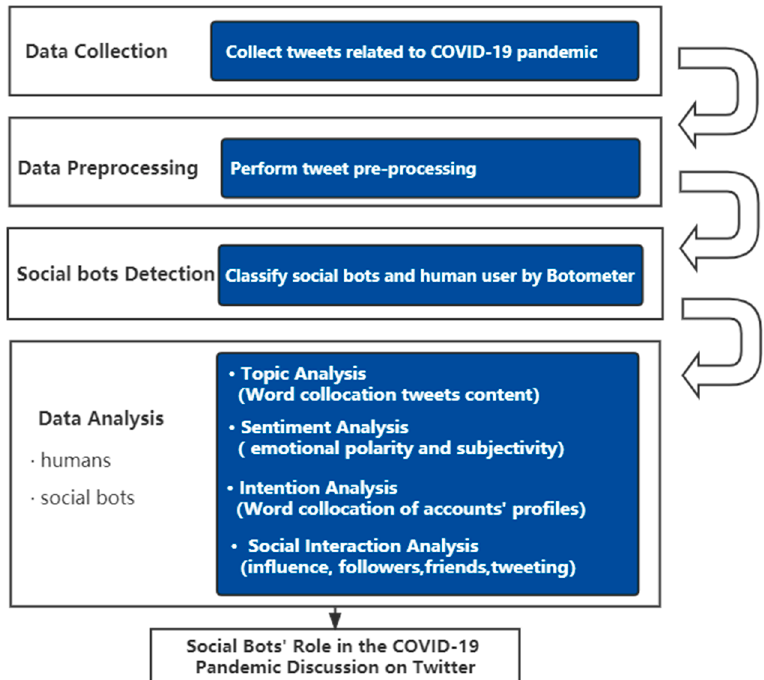
Figure 1. Overview of research structure .